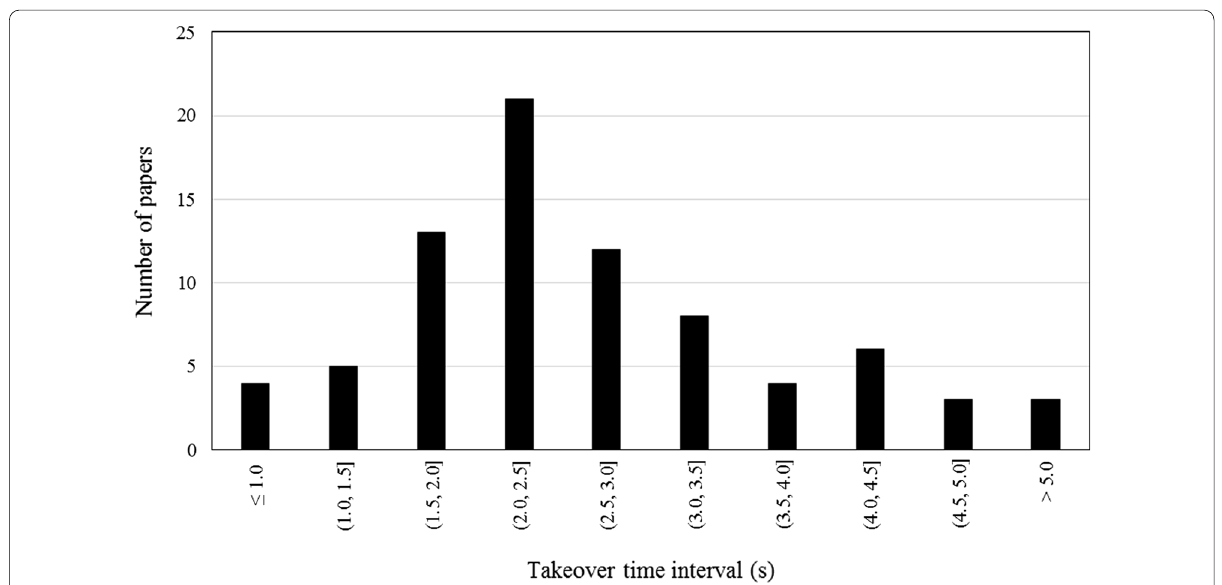
Fig. 2 Mean takeover times extracted from the analysed